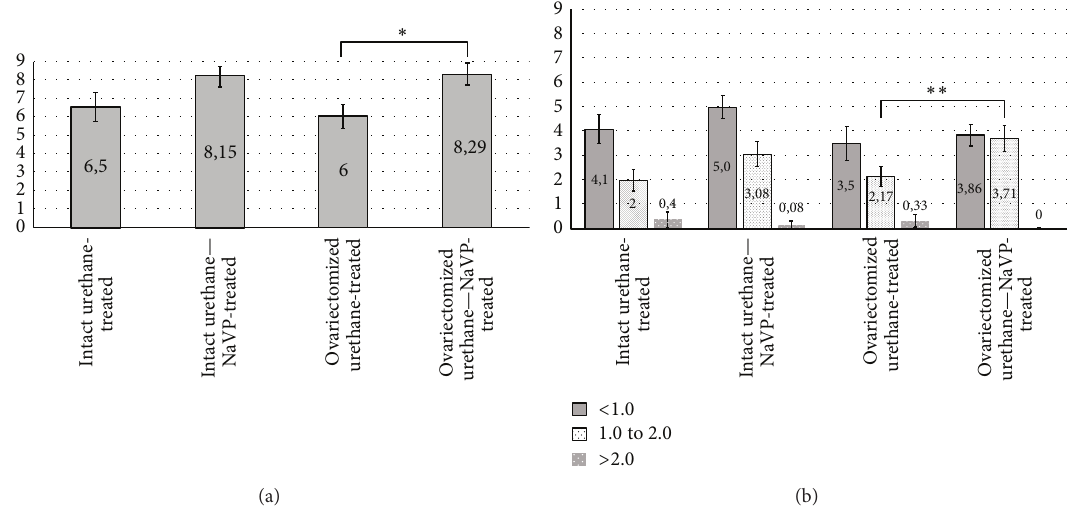
Figure 2: Number of tumors in intact and ovariectomized mice groups. (a) Total number of tumors on the surface of the lungs. ∗ 𝑝 < 0.02 in comparison with the ovariectomized urethane-treated group. (b) Tumors in accordance with tumor diameter. ∗∗ 𝑝 < 0.05 in comparison with the ovariectomized urethane-treated